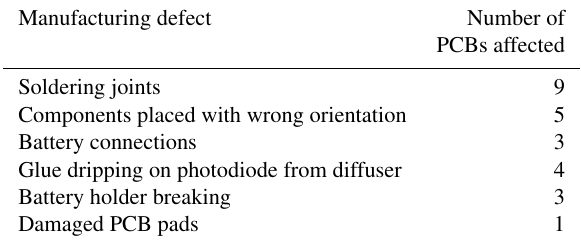
Table 1. Estimated list of defects associated with PCBs created by the